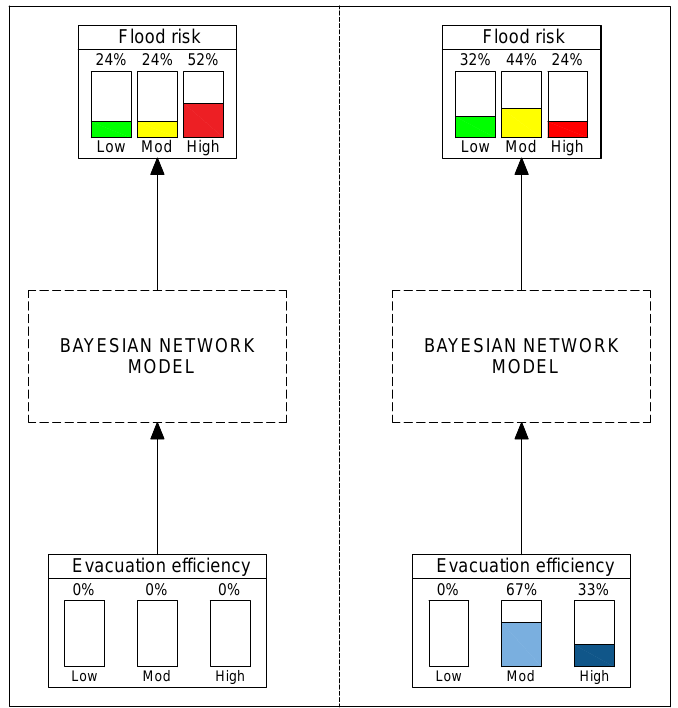
Figure 16. Estimated flood risk with no evacuation ( left ) and with evacuation ( right ).